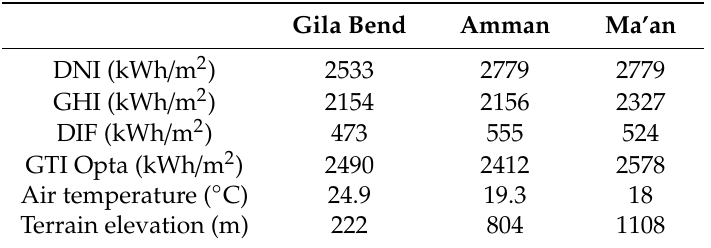
Table 4. Climate conditions for the considered